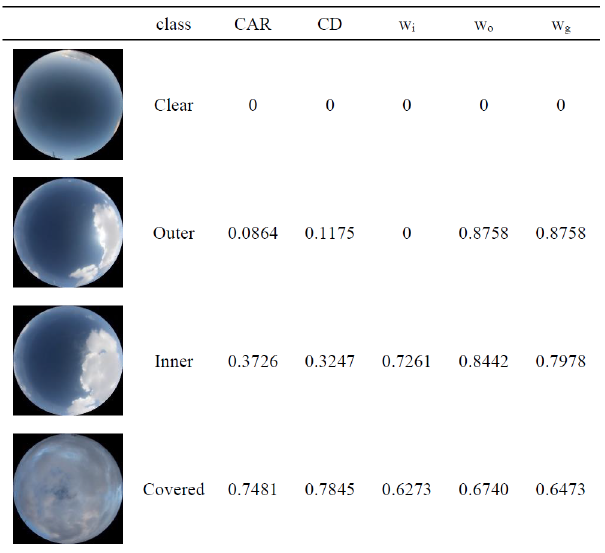
Table 2. Examples of cloud cover features for each type of ASC